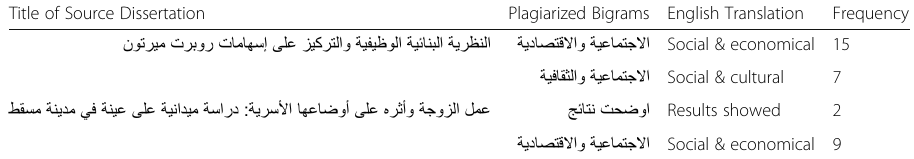
Table 9 Samples of unique bigrams labeled as plagiarized